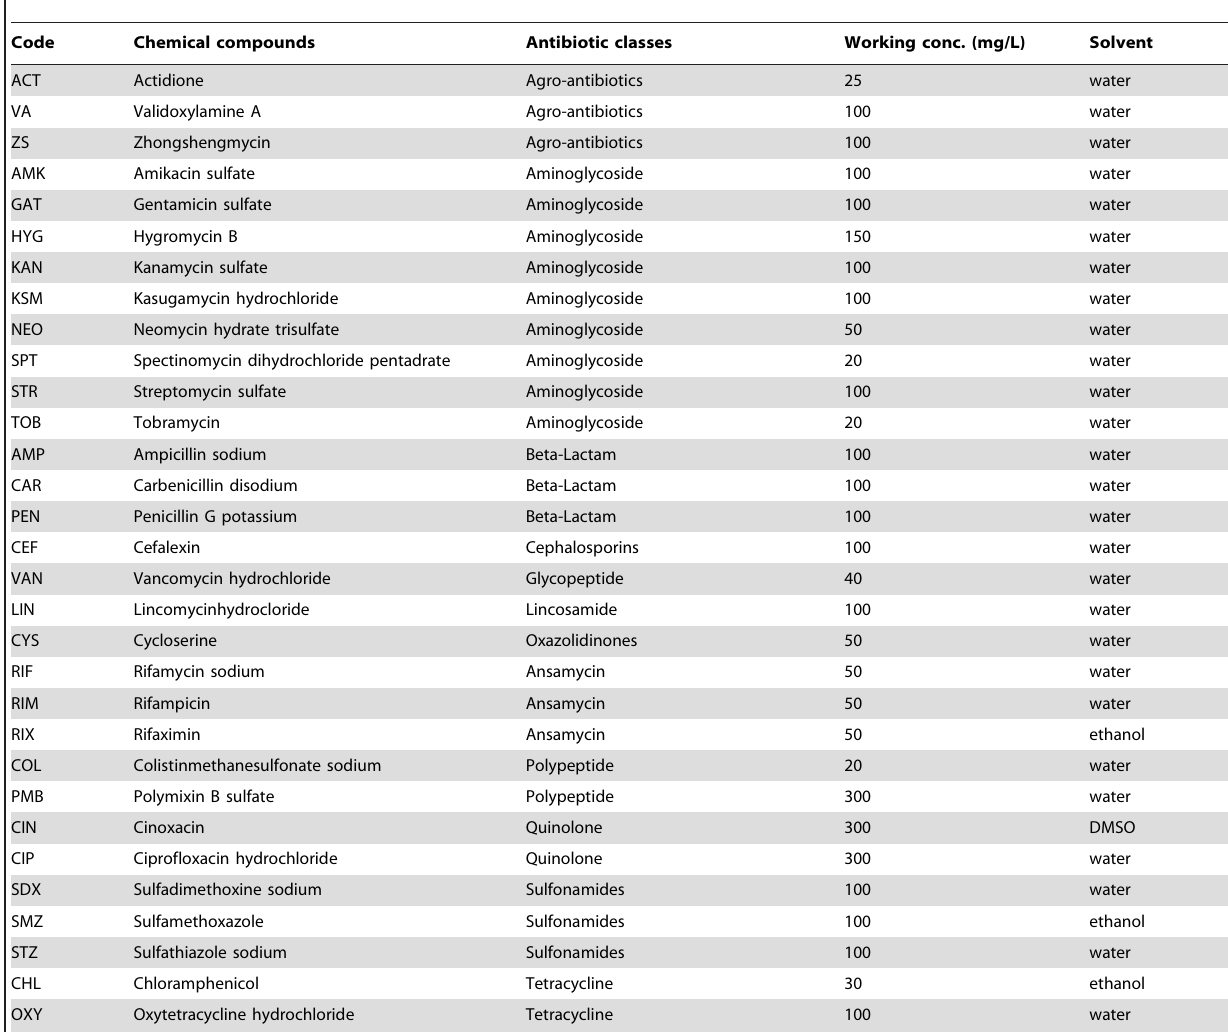
Table 1. Antibiotics screened for the control of citrus Huanglongbing and the concentrations used.